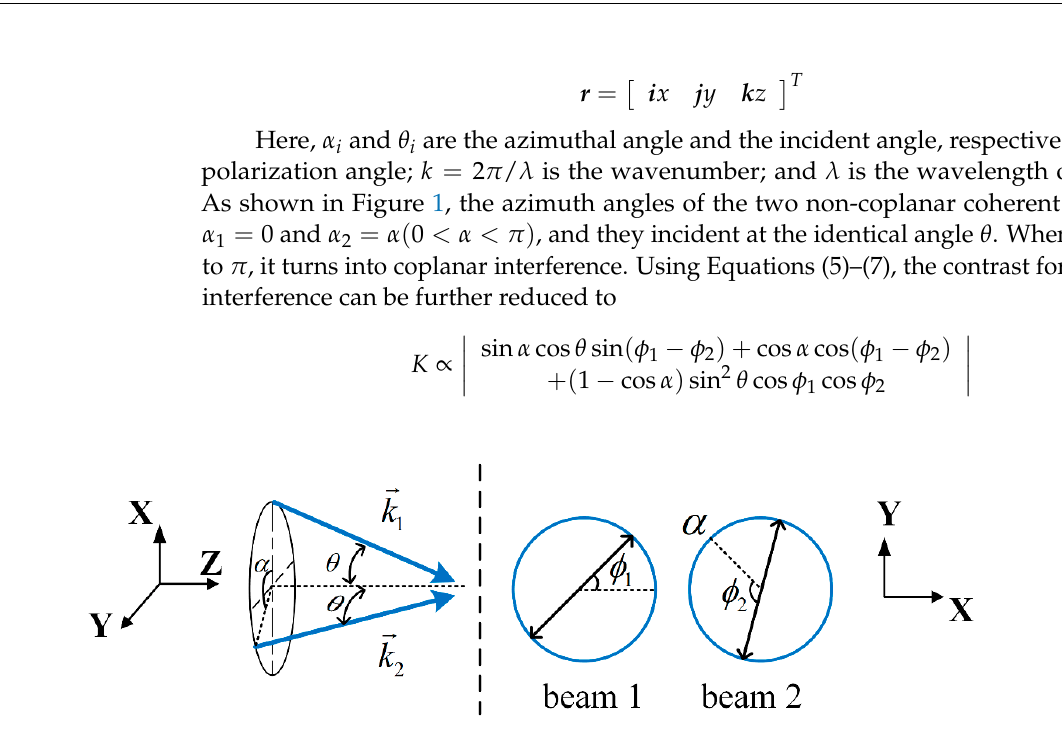
Figure 1. Wave vectors and the coordinate system for double beam interference. Both incident directions of the two beams are on the cone line of the conical surface.